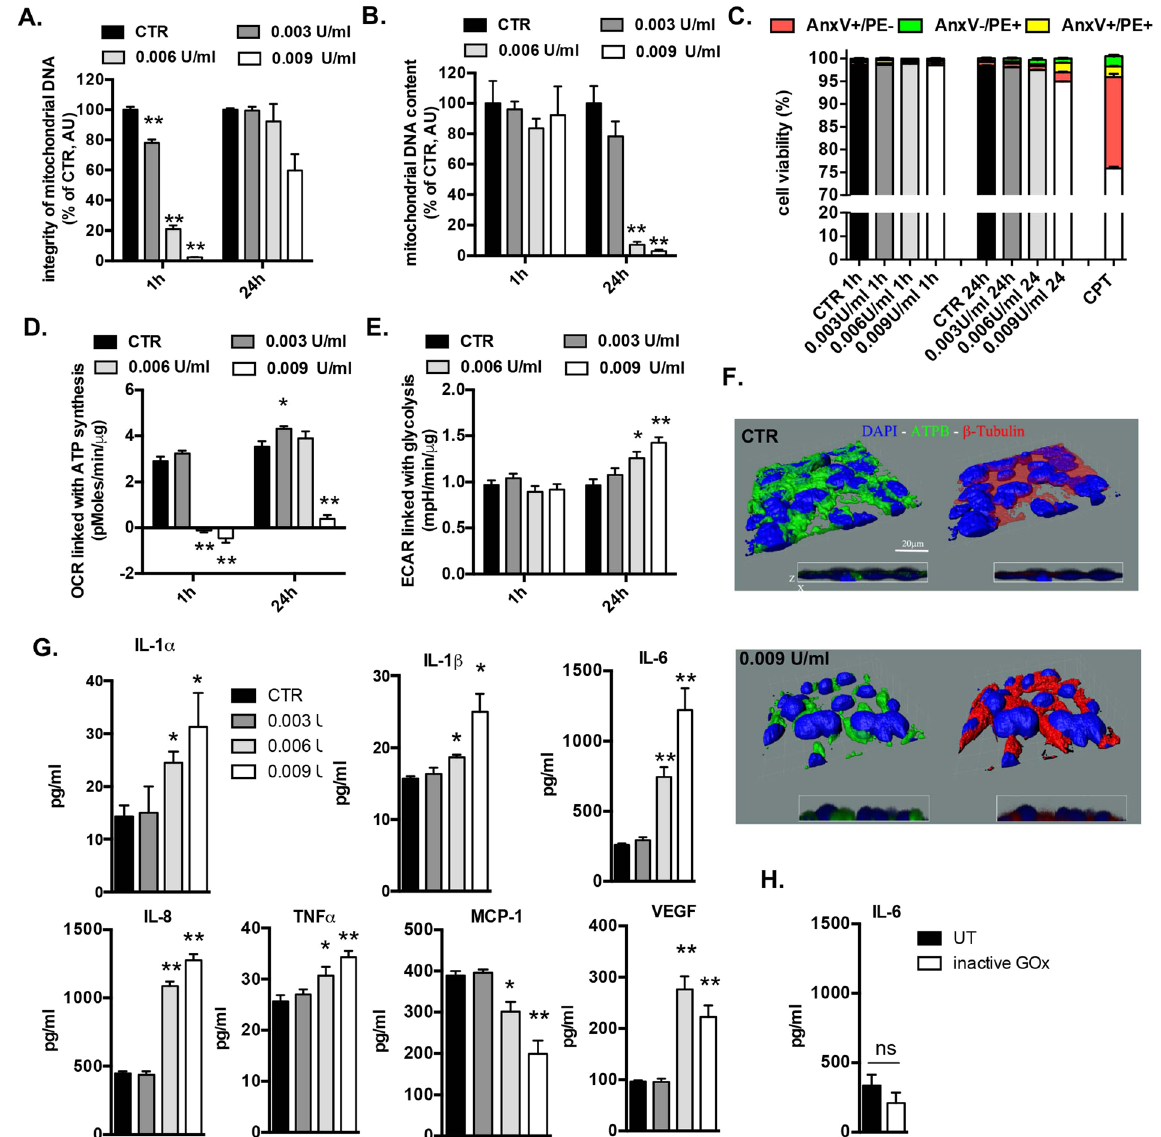
Figure 2. Non-cytotoxic levels of oxidative stress induce mitochondrial DNA depletion, impair cellular bioenergetics and stimulate inflammation. BEAS2B cells were treated with several concentrations of GOx for 1 h and immediately post-challenge as well as 24 h later were measured: ( A ) mitochondrial DNA integrity, ( B ) mitochondrial DNA content, ( C ) apoptotic/necrotic cell death; ( D ) mitochondrial respiration; ( E ) glycolysis. ( F ) 3-D reconstruction of cellular morphology of BEAS2B at 24 h after GOx-treatment was visualized using ATPA-specific antibody (green), β -tubulin (red) and nucleus (DAPI, blue). ( G ) Amount of pro-inflammatory mediators in medium of BEAS2B cells measured at 24 h post GOx-treatment. Data represent average ± SEM of n = 5 biological replicates. ( H ) Lack of enhanced production of IL-6 in BEAS 2B cells stimulated with inactive GOx at 24 h. Representative data of n = 3 independent experiments are shown. * p < 0.05, ** p < 0.01 vs .